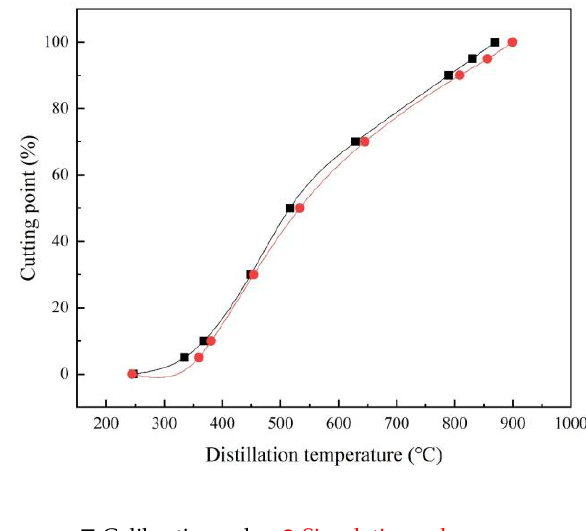
Figure 6. Comparative analysis of feed distillation data.